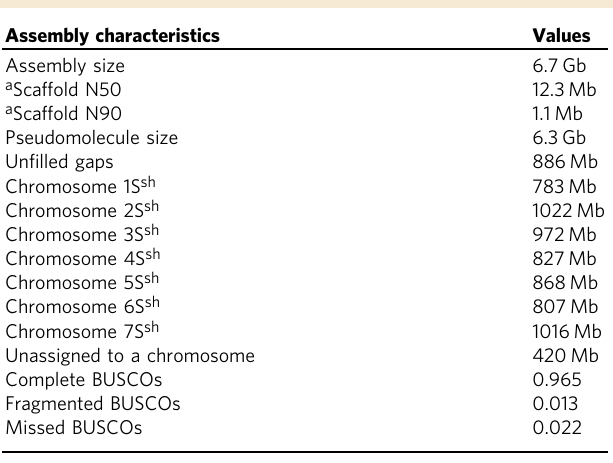
Table 1 Aegilops sharonensis AS_1644 v 1.0 genome assembly